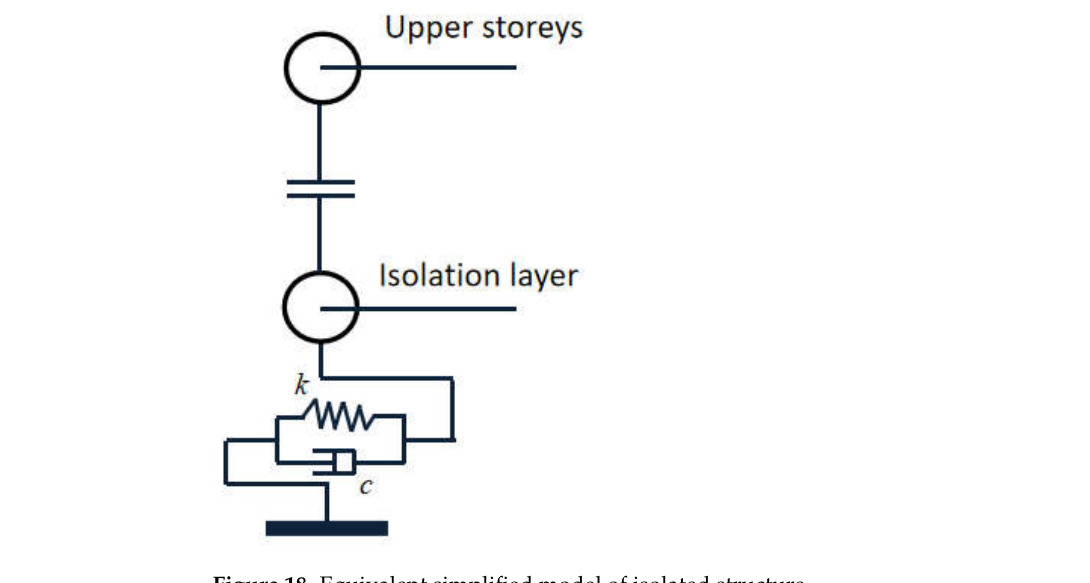
Table 2. Seismic-wave recording parameters.